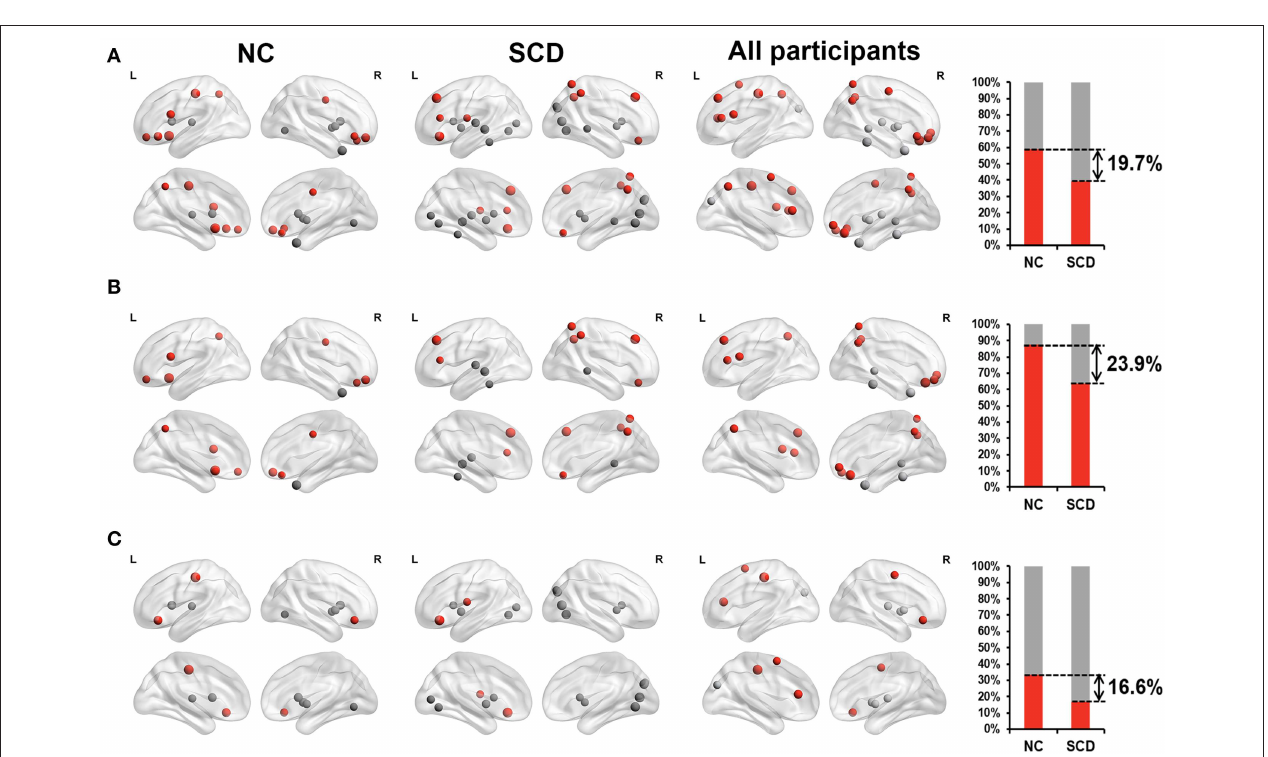
FIGURE 2 | Relationship between Z -scored degree centrality measured by static functional connectivity of brain regions and neuropsychological tests in NC group (the first column), SCD group (the second column) and all participants (the third column). The forth column showed the proportion of significant correlated regions ( p < 0.05) located in anterior (red) cortical and other (gray) cortical regions in the two groups. The nodes covered by red are located in anterior cortical regions. By contrast, nodes covered by gray are located in posterior cortical regions or subcortical regions. The size of each node represents the absolute value of standardized ß. Nodes are located according to their centroid stereotaxic coordinates. (A) All the significant correlated regions ( p < 0.05). (B) The regions in the default mode network. (C) The regions out of the default mode